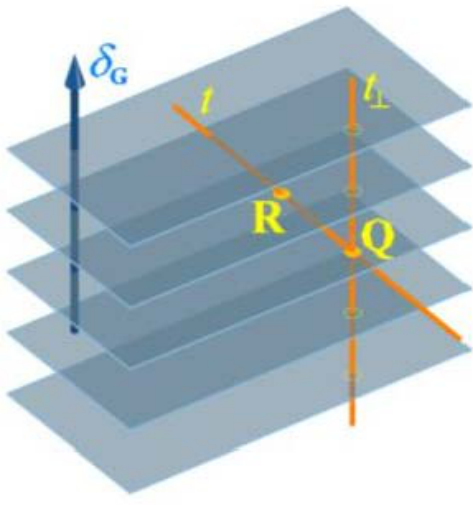
Figure 21: Relation of orthogonality between δ G and the equipoten- tial planes of Φ 0 ( P )